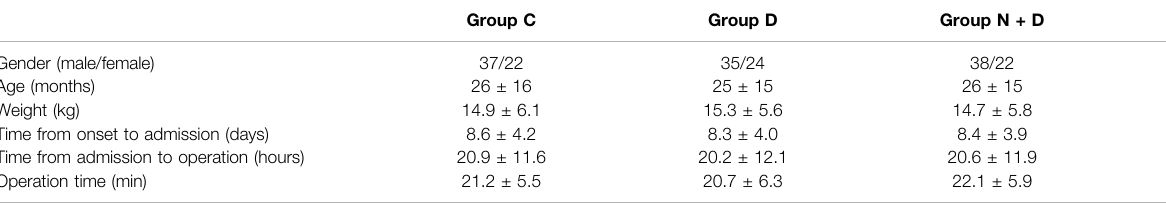
TABLE 1 | Demographics of patients in each group ( (cid:1) x ± s ).